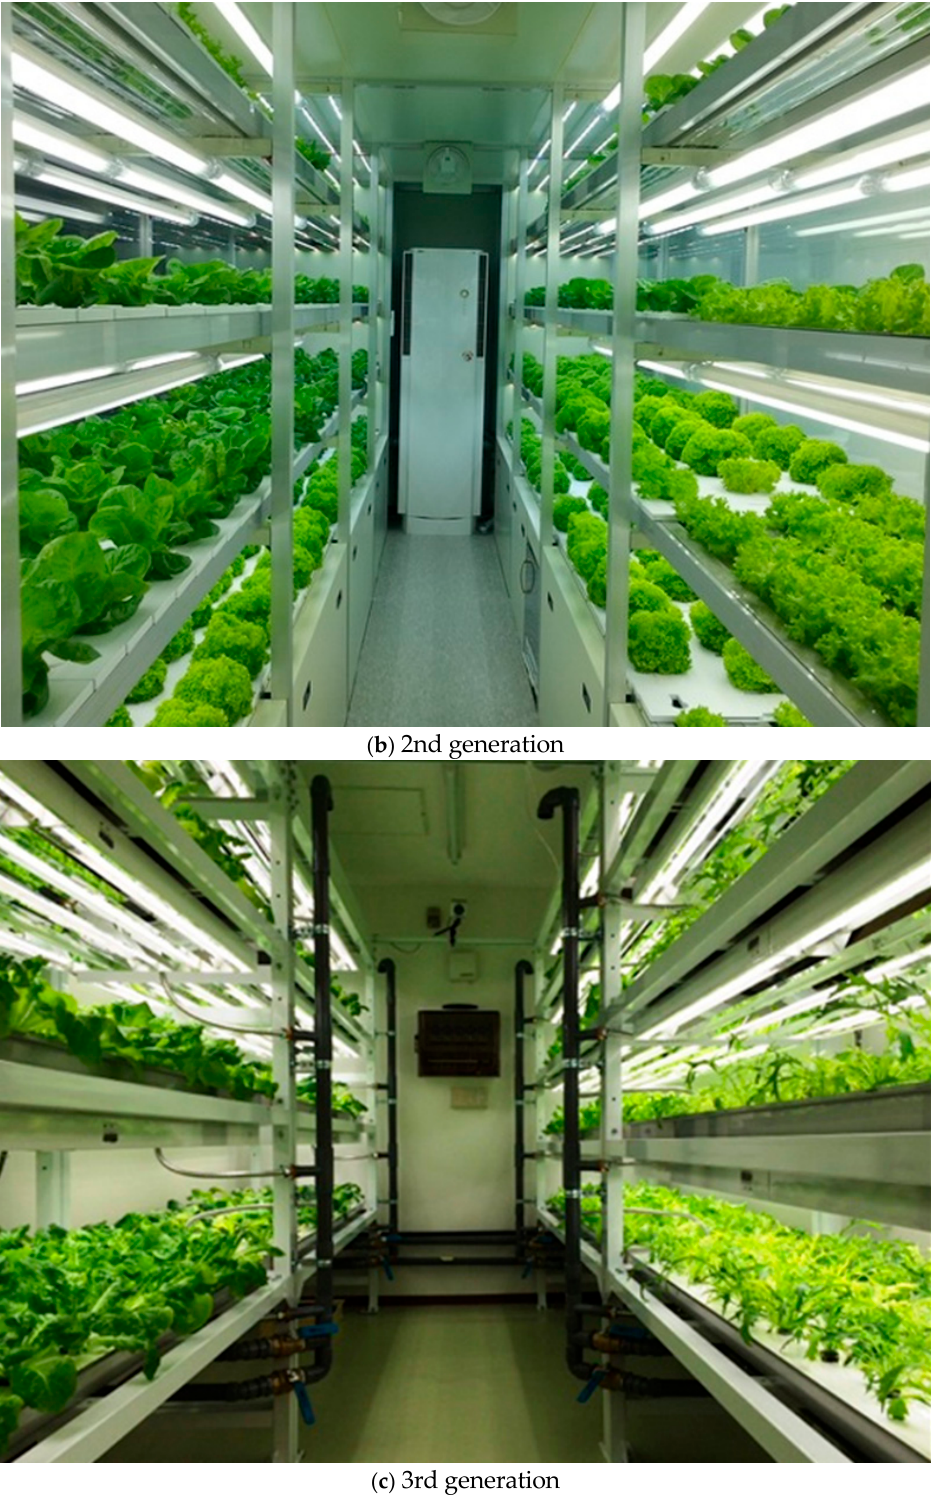
Figure 1. Lighting and Environmental Control with Technological Proposal for Crop Growing Factory. ( a ) The early plant factories that control temperature, humidity, and CO 2 by adjusting lighting and ventilation (1st generation). ( b ) The Information and Communications Technology (ICT)-applied plant factories that create a proper lettuce growing environment by controlling indoor air quality with air purifier (2nd generation). ( c ) The Internet of Things (IoT)-applied plant factories that monitor the lettuce growing process in real-time through CCTV operation and indoor air quality control (the 3rd generation system being proposed in this paper).